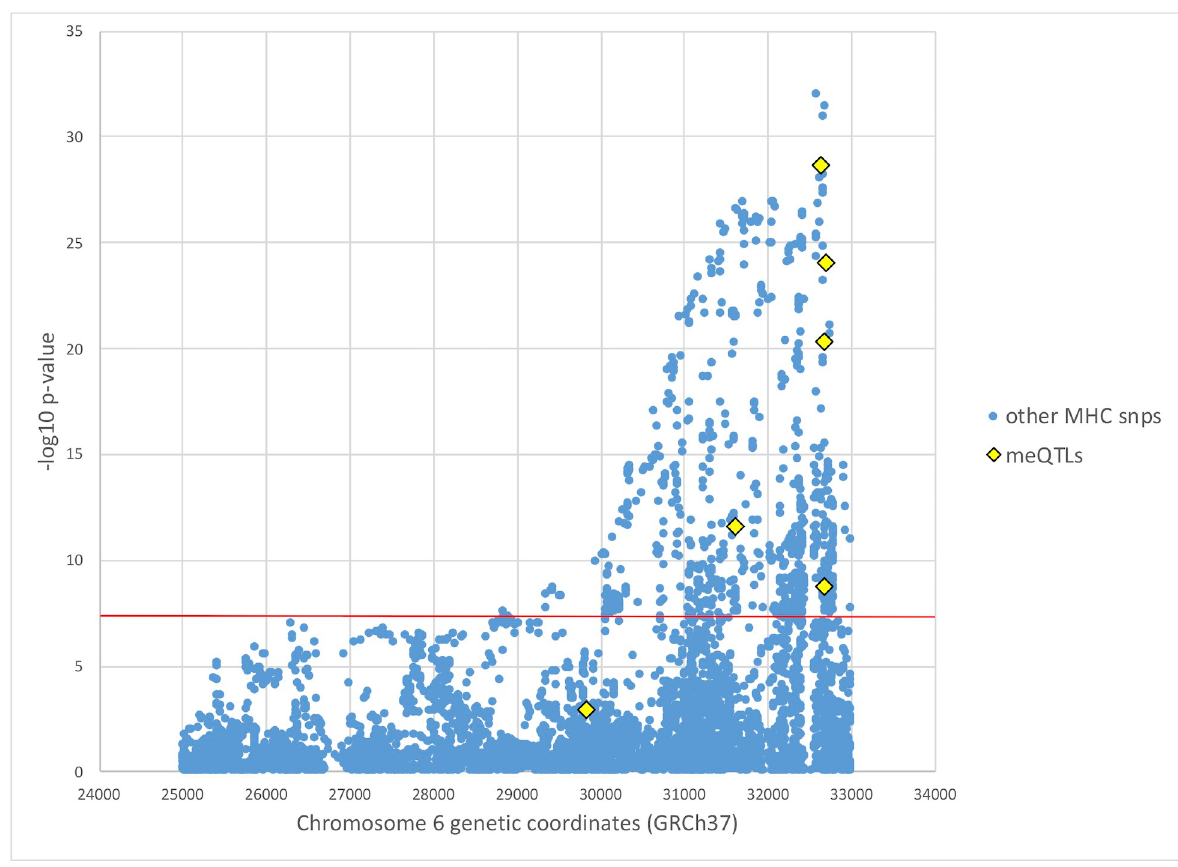
Fig 3. Manhattan plot of SS GWAS results at the MHC. European SS GWAS results at the MHC from Taylor et al . [7], with mediating meQTL p- values from this study colored in yellow. SS case status was determined based on the 2016 ACR/EULAR classification criteria [32]. The red horizontal line indicates genome-wide significance level of p-value < 5 × 10 − 8